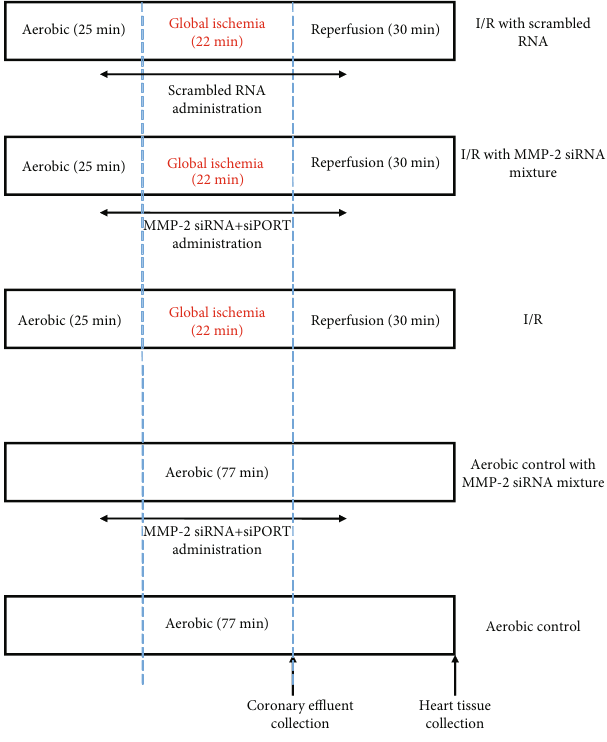
Figure 1: Experimental protocol for I/R and aerobic control with or without MMP-2 siRNA/scrambled RNA and siPORT mixture infusion. The hearts were perfused with MMP-2 siRNA/ scrambled RNA and siPORT mixture for the last 10 minutes of aerobic stabilization and the fi rst 10 minutes of reperfusion. I/R: